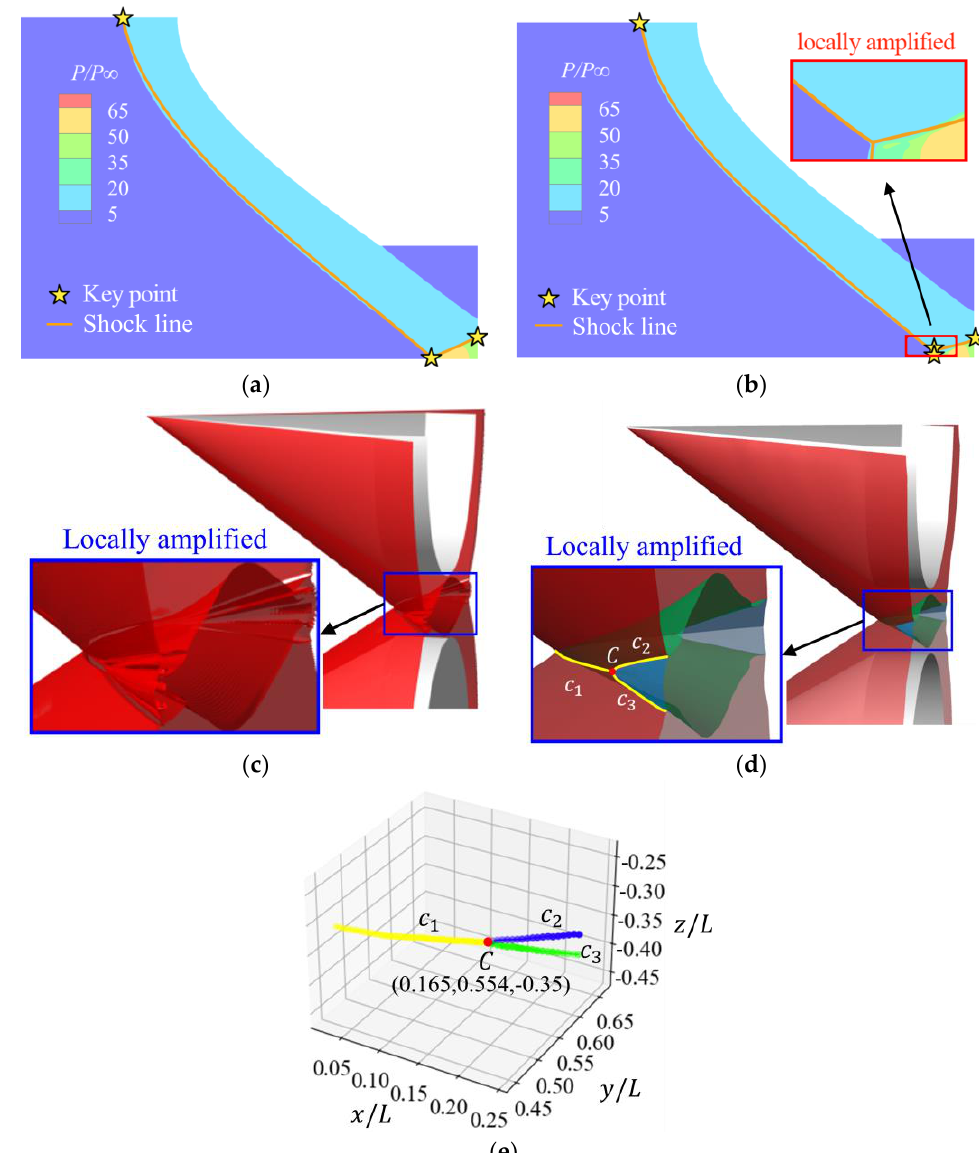
Figure 11. Shock detection results: ( a , b ) the pressure contours and two-dimensional shock topology recognition results on two slices near the transition point C, ( c , d ) local shock surfaces near the interaction line by the traditional method and the method proposed by this study, ( e ) coordinates of the interaction lines and the transition point.